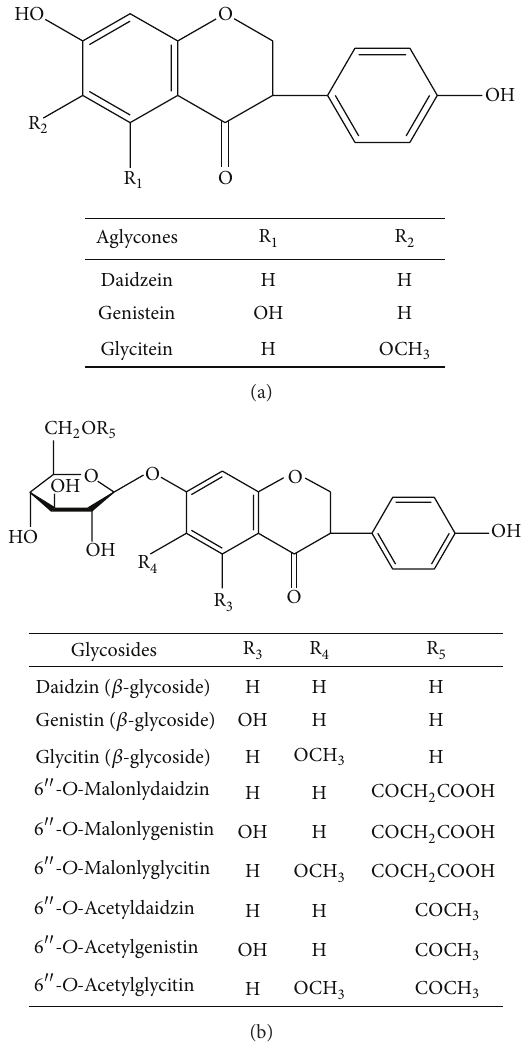
Figure 1: Structure of isoflavones in the forms of aglycones (a), 𝛽 - gly-cosides, 6 󸀠󸀠 - O -acetyl- 𝛽 -glycosides, and 6 󸀠󸀠 - O -malonyl- 𝛽 -glyc- osides